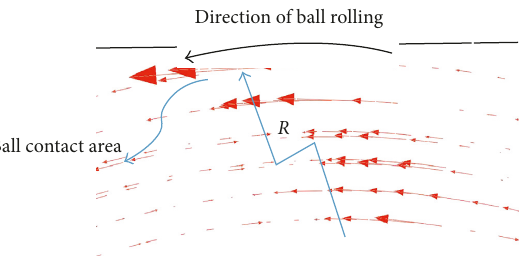
Figure 11: Flow vector diagram of nodes of cross section at the contact area